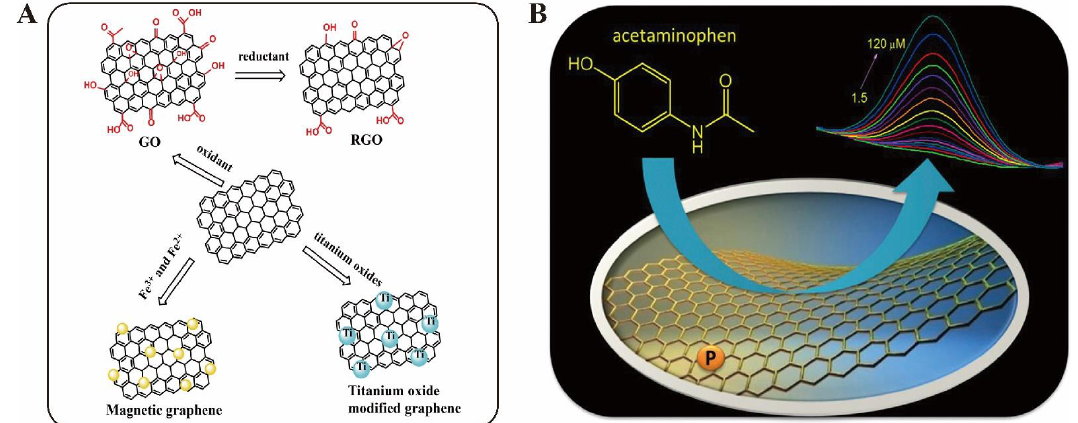
Figure 4. Electrochemical analysis for antibiotic detection based on graphene and its derivatives. ( A ) Functionalization of graphene [36]. ( B ) Phosphorus-doped graphene-based electrochemical sensor for sensitive detection of acetaminophen [37].